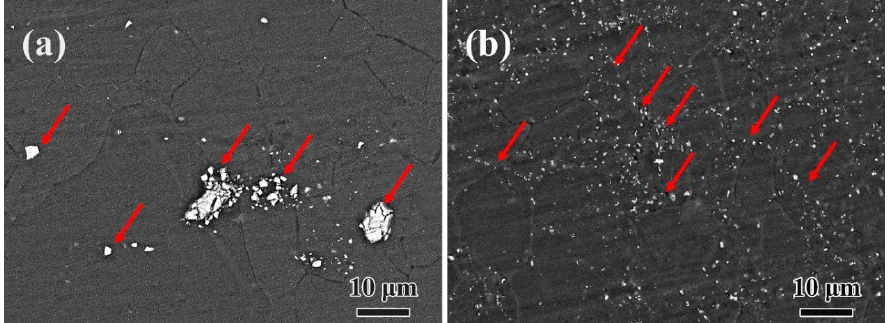
Figure 4. SEM micrographs of ATM610 alloy sheets: ( a ) extruded sample and ( b ) rolled sample